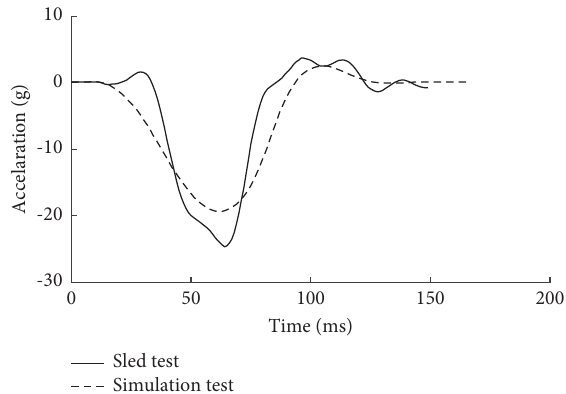
Figure 9: Acceleration curve of the simulation and real sled crash test after filtering at